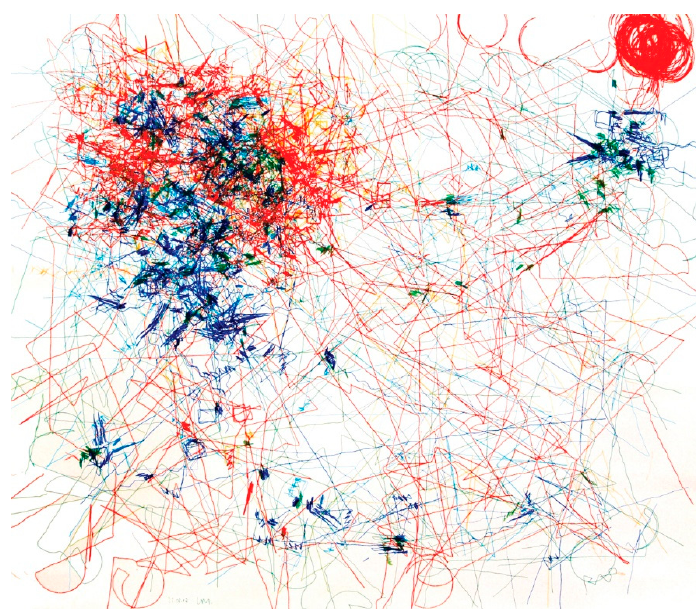
Figure 3. RAP (Robot Action Painting) , 2007, ink on canvas, 150 cm × 170 cm. ©2007 Robotarium and used by permission.